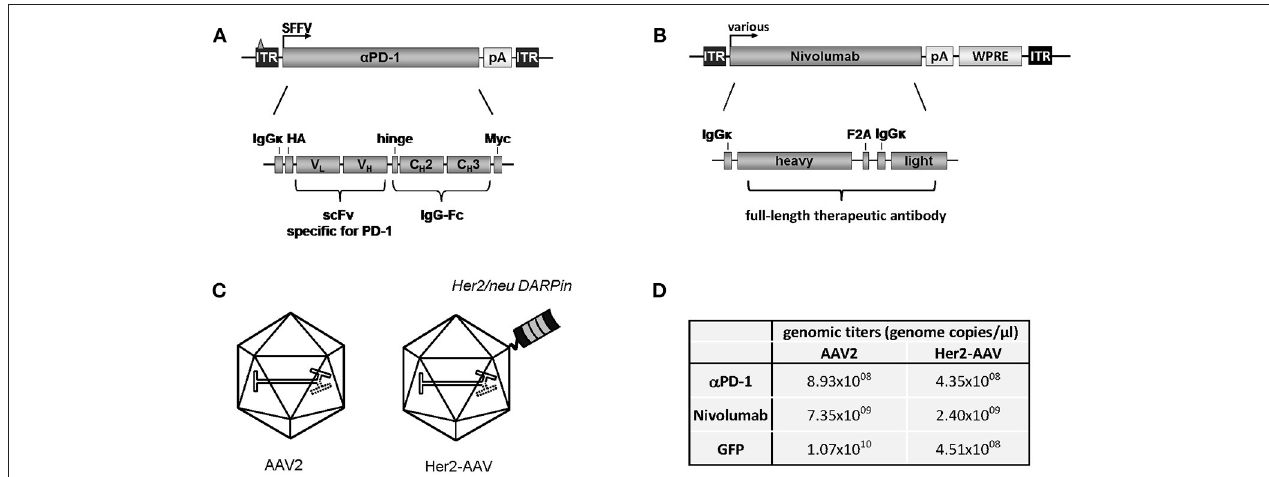
FIGURE 1 | Cloning and characterization of AAV vectors encoding α PD-1. (A) Design of the transfer vector constructs encoding murine α PD-1 or (B) Nivolumab.ITR: inverted terminal repeat (with triangle representing the deleted terminal resolution site sequence in the scAAV construct); SFFV, spleen focus-forming virus; HA, hemagglutinin; V H , variable region of the heavy chain; V L , variable region of the light chain; C H , constant region of the heavy chain; scFv, single chain variable fragment; IgG, immunoglobulin G; Fc, fragment crystallizable; WPRE, woodchuck hepatitis virus posttranscriptional regulatory element; F2A: foot and mouth disease virus-derived self-cleaving peptide. (C) Schematic representation of AAV2 and Her2-AAV. The displayed DARPin providing Her2/neu specificity is depicted on the capsid surface. (D) Representative genomic titers of the indicated gradient-purified large-scale vector stocks.